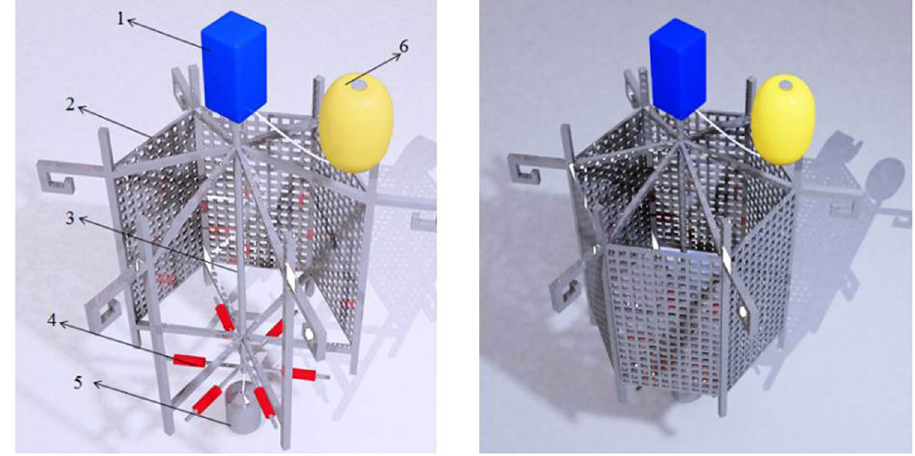
Figure 10. Passive sampler with a sorptive stir bar extraction (SBSE):1, speed control system; 2, metal cage; 3, driving rod; 4, stir bar;5, lead ore;6,